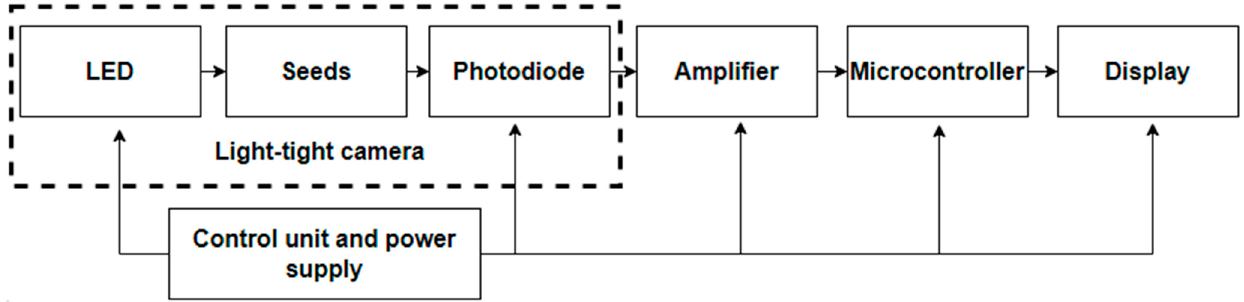
Figure 4. Block diagram of the seed scarification quality-control device.